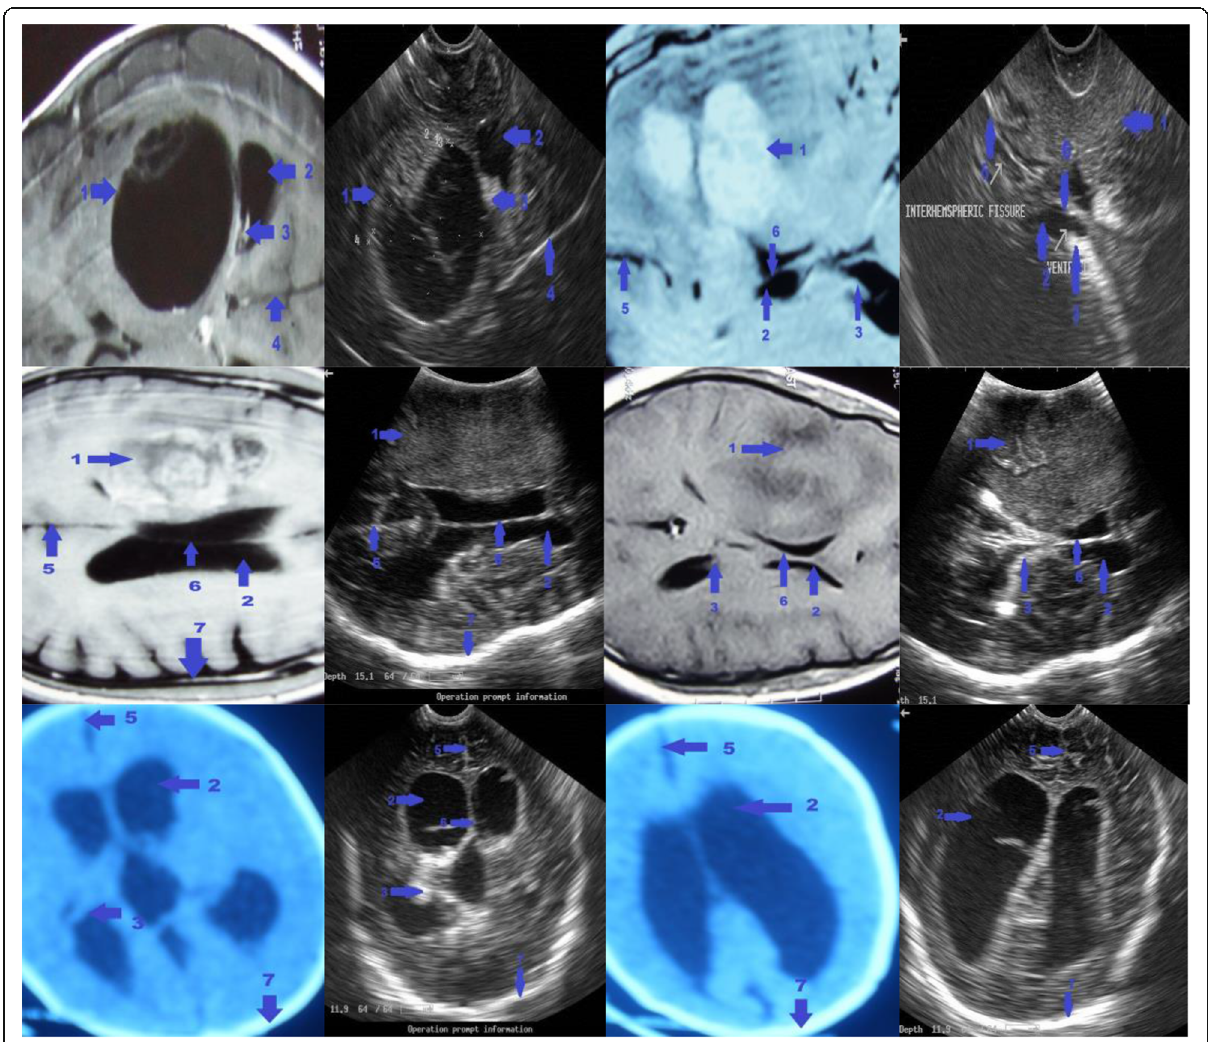
Fig. 6 Ventricular system; arrow1 brain mass lesion, arrow2 homogenous hypo-echogenic cerebrospinal fluid, arrow3 homogenous hyper- echogenic choroid plexus, arrow4 homogenous hyper-echogenic falx, arrow5 heterogeneous hyper-echogenic inter-hemispheric fissure, arrow6 homogenous hyper-echogenic septum pellucidum, and arrow 7 homogenous hyper-echogenic